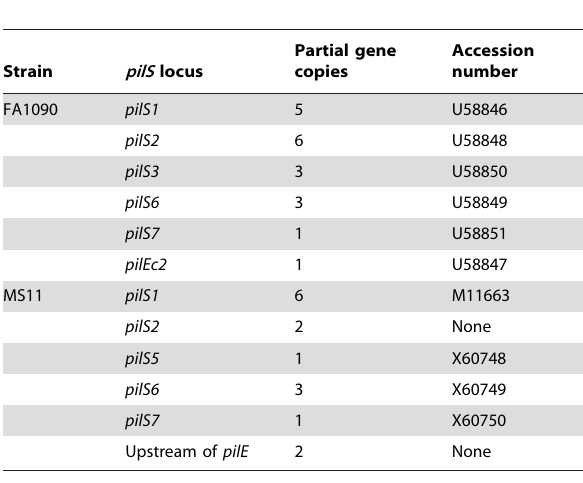
Table 1. Partial pilE gene copies found within the pilS loci of N. gonorrhoeae